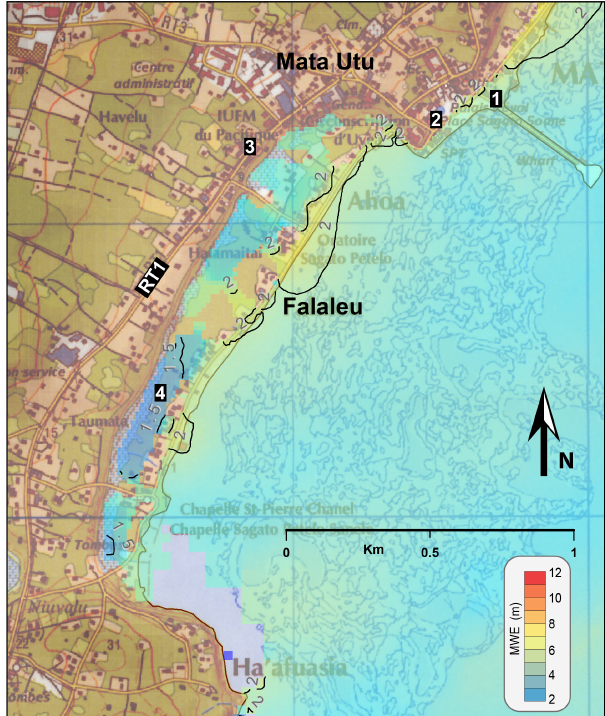
Figure 10. Maximum wave elevation and inundation map along the coast of central Uvéa (Wallis) from an M W = 9.1 Tonga Earthquake (Sc. 8, Table 4). The 2m MWE contour is drawn in places. Model generated using the Gerris flow solver. 1: port facilities; 2: Post Of- fice and meeting place; 3: Teacher college; 4: Taro crops. RT1: Ter- ritorial Road